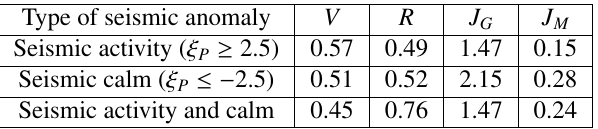
Table 1. Predictive e ffi ciency of the parameter ξ P